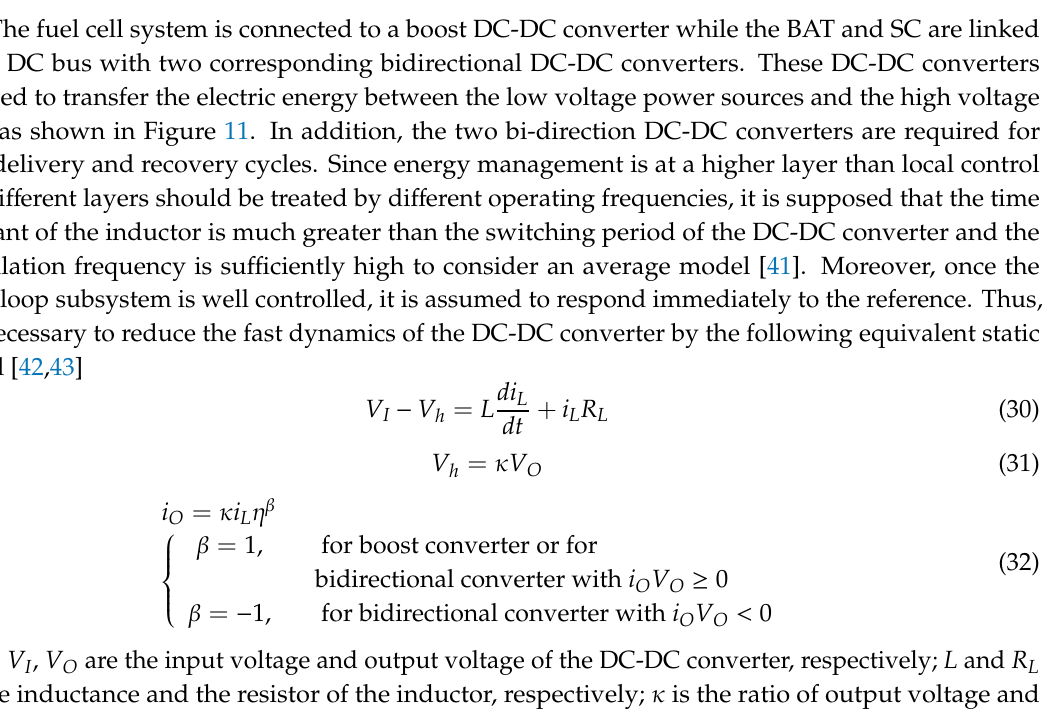
Figure 11. DC/DC converter electric circuit. 4.5. Excavator Hydraulic Model